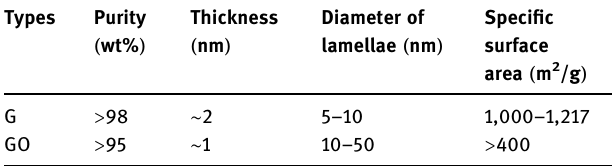
Table 2: Physical parameters of G and GO